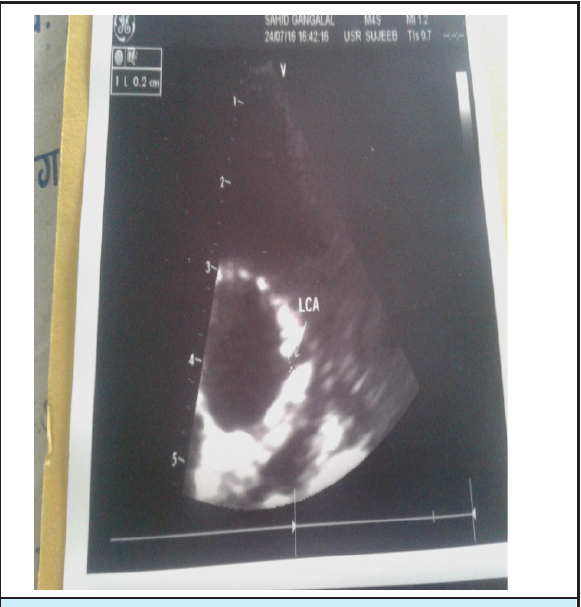
Figure 2. Edema of the feet, right ankle. Figure 3. ECHO-on the left shows normal size Left coronary